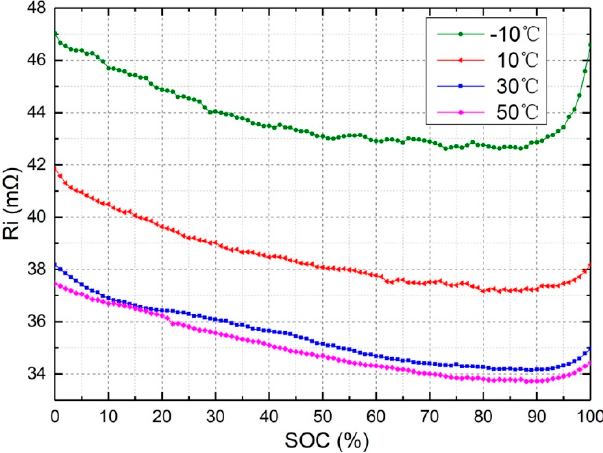
Figure 5 . R i -SOC plot with different temperatures.